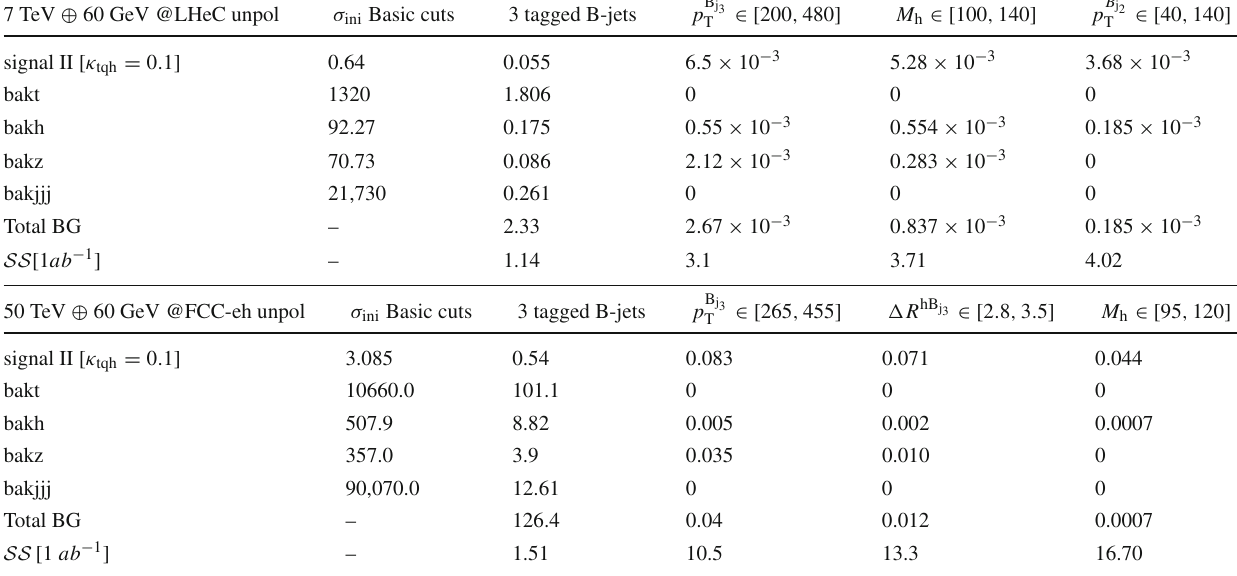
Table 2 Cross sections (in units of fb) and significance depending on the cut flows for signal II e − p → ν e hb → ν e b ¯ bb ( κ tuh = 0 . 1) and backgrounds at the 7 TeV ⊕ 60 GeV @LHeC and 50 TeV ⊕ 60 GeV